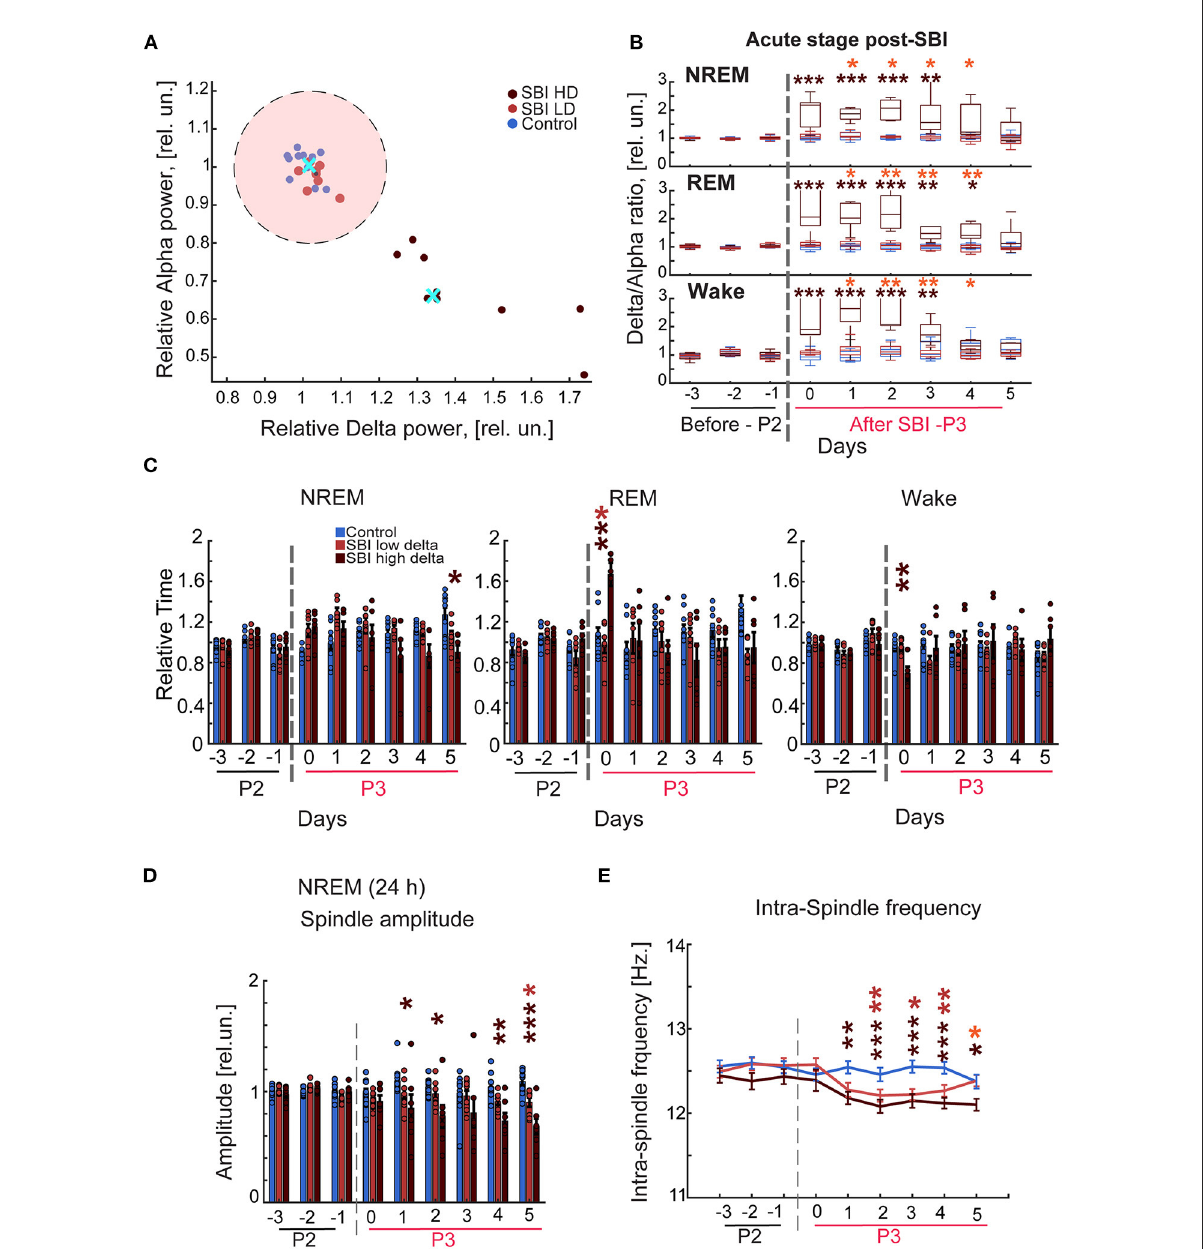
FIGURE2 Blast injured mice exhibit an excessive sleep pattern during the acute stage post-injury. (A) Representative scatter plot of the delta-alpha scores obtained from SBI and sham mice during day 2 after trauma (period 3, P3) and normalized to the delta/alpha ratio before blast injury (period 2; P2). Data were clustered into two groups using the K -means function: mice with a high (HD) and low (LD) delta/alpha ratio. The cluster centroids (cyan cross) represent the average of delta and alpha power relative scores, and the pink circle depicts 90% of the mean distance between the centroid of the cluster containing control animals and LD. Carmine dots represent SBI mice assigned to the cluster of low delta/alpha ratio ( n = 8); brown dots, SBI mice assigned high ratio ( n = 8), and blue dots correspond to the control group ( n = 11). (B) Delta alpha ratio differences between SBI-HD ( n = 7), SBI-LD ( n = 8), and sham mice ( n = 11) in NREM, REM, and Wake state before and after blast induced-injury (dashed gray line). (C) NREM, REM, and awake episode duration over 24h in SBI-HD ( n = 7), SBI-LD ( n = 8) and sham mice ( n = 11) and normalized to averaged episode duration before SBI. (D) Average peak domain amplitude (mean ± S.E.M.) in microvolts of the detected spindles in 24-h periods and normalized to the averaged peak found before SBI represented in relative units (rel.un.). (E) Averaged intra-spindle frequency distribution (mean ± S.E.M.) in detected spindles during 24h in SBI-HD, SBI-LD and control mice days before and after causing SBI. We employed Kruskal Wallis and Dunn’s test with Bonferroni correction, * p < 0.05, ** p < 0.01, *** p < 0.001. Carmine asterisks represent differences between sham and SBI-LD, brown asterisks depict differences between SBI-HD and sham mice, and the orange asterisk display differences between SBI-HD and SBI-LD